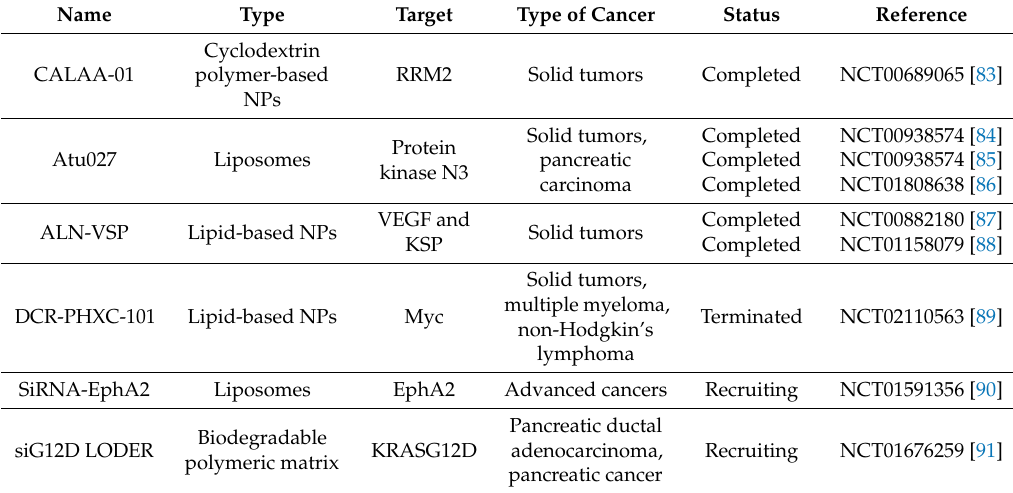
Table 2. Clinical trials with SiRNA-loaded